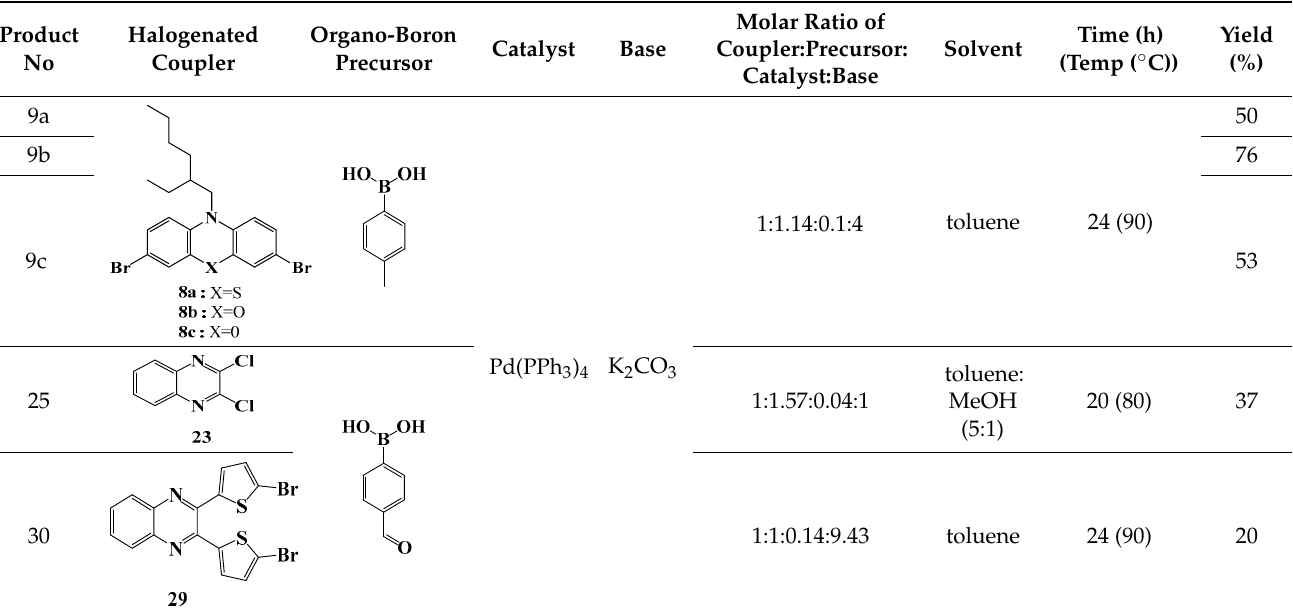
Table 2. Summary of Suzuki cross-coupling reactions of halogenated N -alkyl PTZ, POZ Cz, and QX couplers with commercial arylboronic acid precursors.